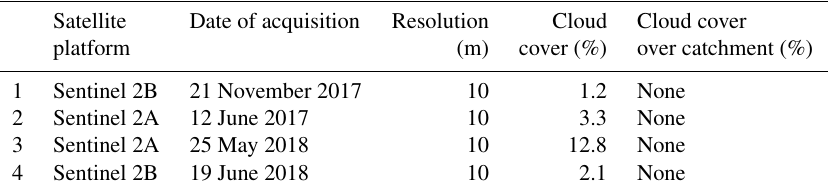
Figure 8. Same as Fig. 5b for (a) the all distributed run (2D-AD), (b) the only precipitation distributed run (2D-PD), (c) the only shortwave radiation distributed run (2D-SD), and (d) the only wind speed distributed run (2D-WD). Table 3. Image characteristics from ESA’s Sentinel-2